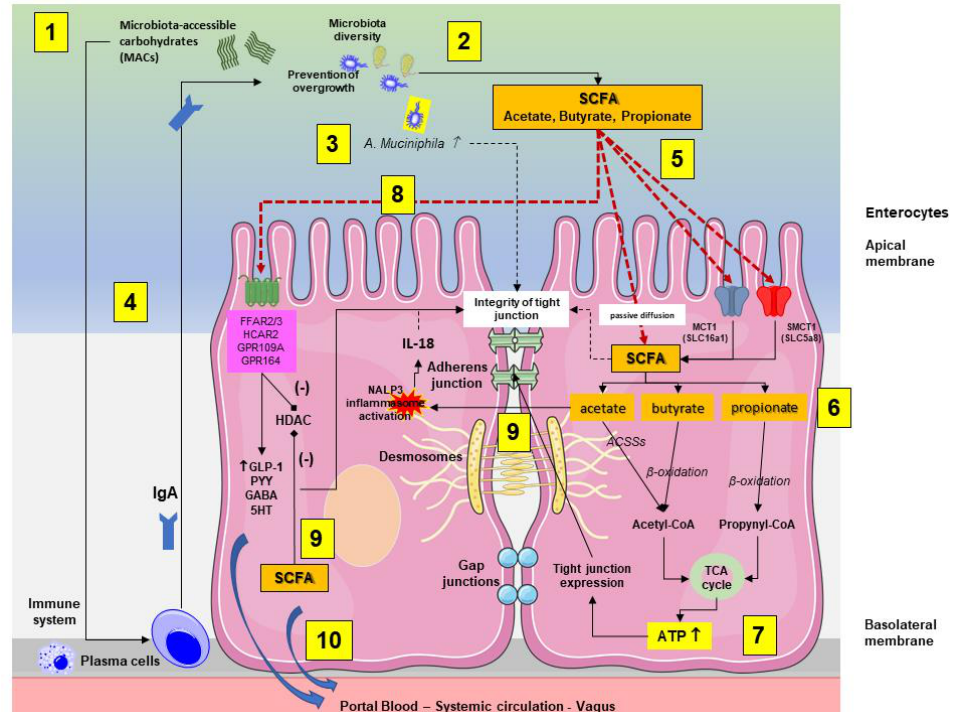
Figure 3. Interplay between the microbiota-accessible carbohydrates (MACs), the gut microbiota, the production short chain fatty acids (SCFAs), and the enterocytes (mainly colonocytes). The main pathways involved are summarized in the two enterocytes. ( 1 ) Following initial digestion and intestinal transit, the dietary MACs meet the gut microbiota, which is characterized by high and physiological diversity and no bacterial overgrowth. ( 2 ) SCFA-producing bacteria, mainly in the colon, will digest MACs and increase the luminal content of SCFAs. ( 3 ) In this environment, the abundance of A. muciniphila increases and is associated with protective effects on mucin and tight junction integrity. ( 4 ) In addition, a diet enriched in MACs will positively stimulate the immune system, leading to plasma cell-mediated production of immunoglobulins A (IgA) with further control on microbiota function, diversity, and prevention of overgrowth. ( 5 ) In the colonocyte, SCFAs are absorbed by colonocytes via passive diffusion or via active transport mediated by H+-dependent monocarboxylate transporters (MCTs). ( 6 ) The SCFAs acetate, butyrate, and propionate are converted to acetyl-CoA or propynyl-CoA by pathways involving the acetyl-CoA carboxylases (ACSSs) and beta oxidation. ( 7 ) This step produces ATP, which contributes to the maintenance of cell homeostasis, including the function of tight junctions. ( 8 ) Via stimulation of receptors at the apical membrane, SCFAs promote the secretion of gut hormones, such as glucagon-like peptide 1 (GLP1) and peptide YY (PYY), γ -aminobutyric acid (GABA), and serotonin (5-HT). At this level, butyrate inhibits (-) histone deacetylases (HDACs) with consequent anti-inflammatory effect by reducing NF- κ B-induced pro-inflammatory mediators, such as TNF- α , IL-6, IL-12, and iNOS [43]. ( 9 ) Intracellular SCFAs contribute to inhibition (-) of HDAC. Acetate activates the inflammasome nucleotide-binding oligomerization domain 3 (NLRP3) with secretion of the protective IL-18 from epithelial cells, which maintains the tight junction’s function. ( 10 ) Colon-derived SCFAs reach the systemic circulation promoting anti-inflammatory and immunomodulatory effects as well as increasing insulin secretion, maintaining energy homeostasis, and improving liver and brain function.